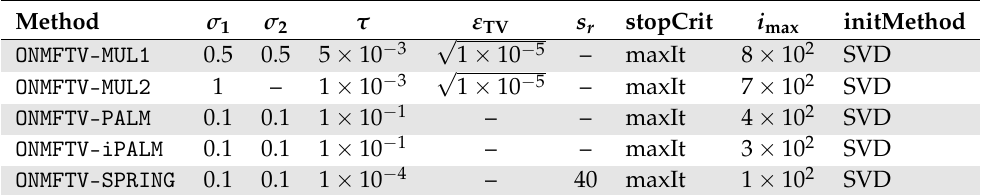
Table A2. Parameter choice of the combined methods for the numerical experiments with the MALDI